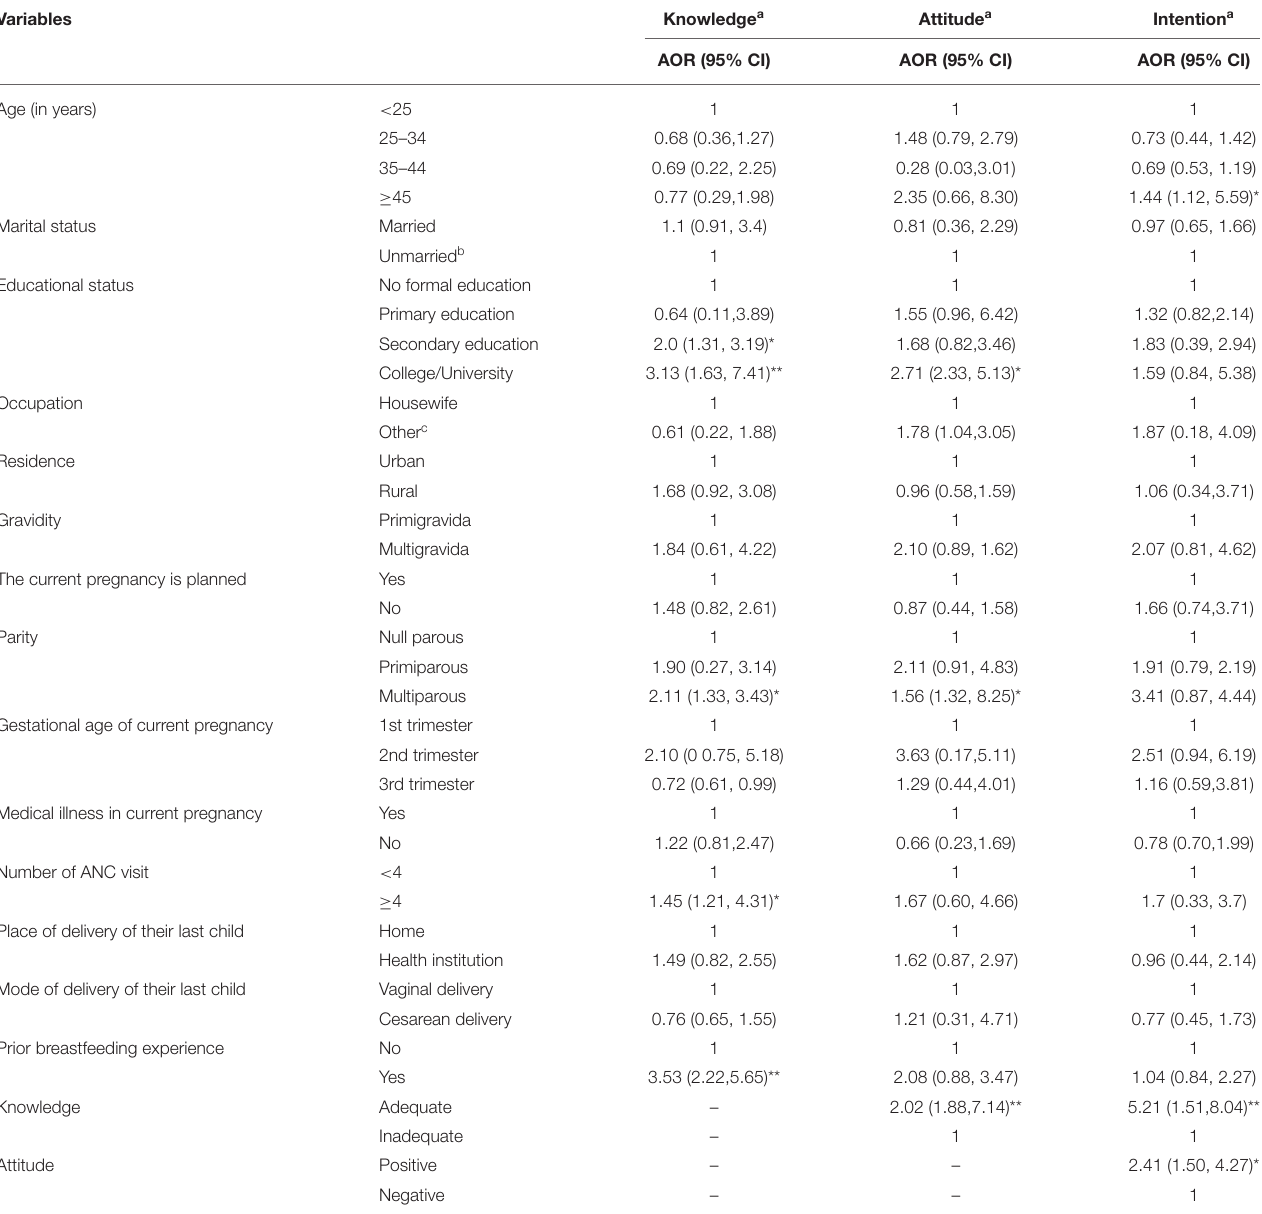
TABLE 4 | Factors associated with breastfeeding knowledge, attitude, and intention among pregnant women attending the MCH clinic of DTCSH in Debre Tabor, Northwest Ethiopia,